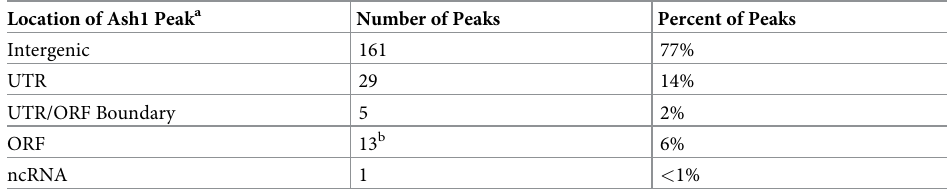
Table 1. Features of Ash1, Tup1, Rpd3 co-localized (ATR) peaks. Location of Ash1 Peak